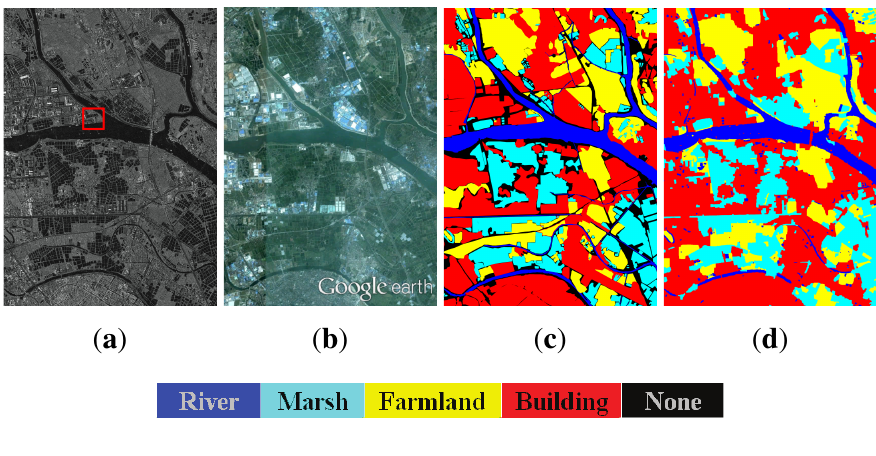
Figure 7. TerraSAR-X data of Foshan city. ( a ) SAR image of Foshan, Guangdong, China; ( b ) Optical image from Google Earth ( c ⃝ Google 2013); ( c ) Visually interpreted map; ( d ) Classification result of MAS + MRF